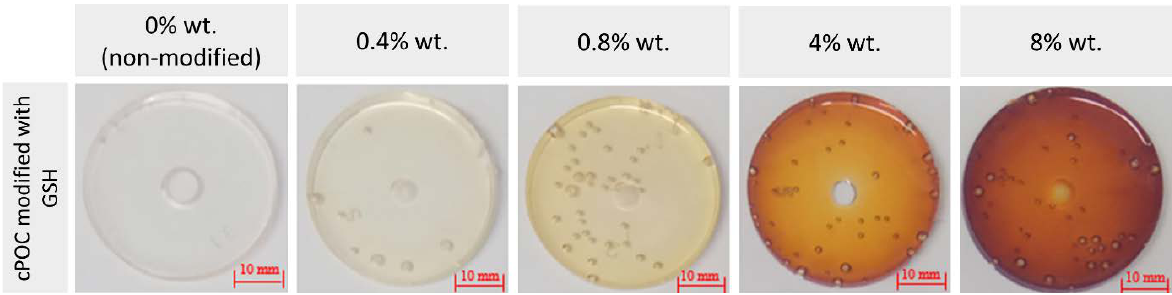
Figure 1. cPOC control sample and cPOC modified with 0.4, 0.8, 4 and 8 wt.% of GSH.